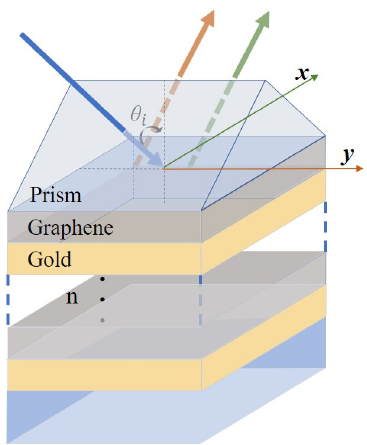
Figure 7. Schematic diagram of n-layer periodic structure.